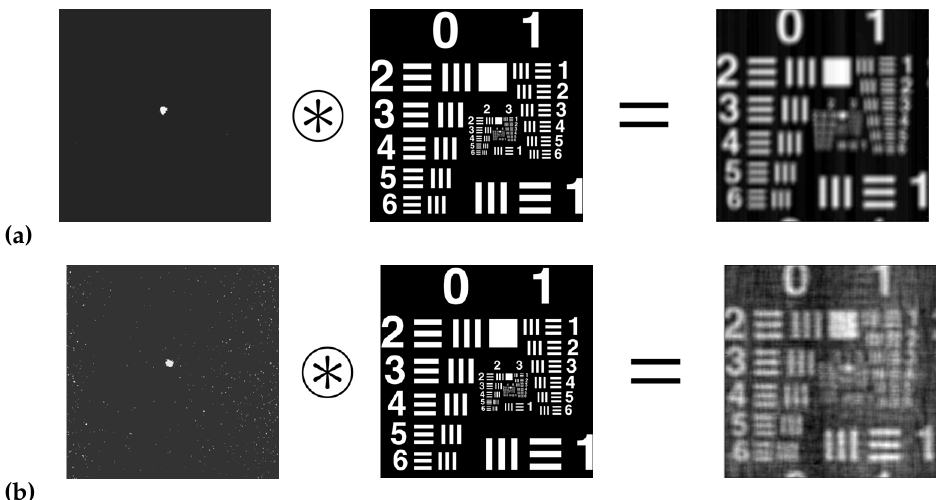
Figure 6. Simulated convolution for negative asymmetrical HLs, with ASF obtained with the CCD sensor, reconstructed at: ( a ) 473 nm, ( b ) 633